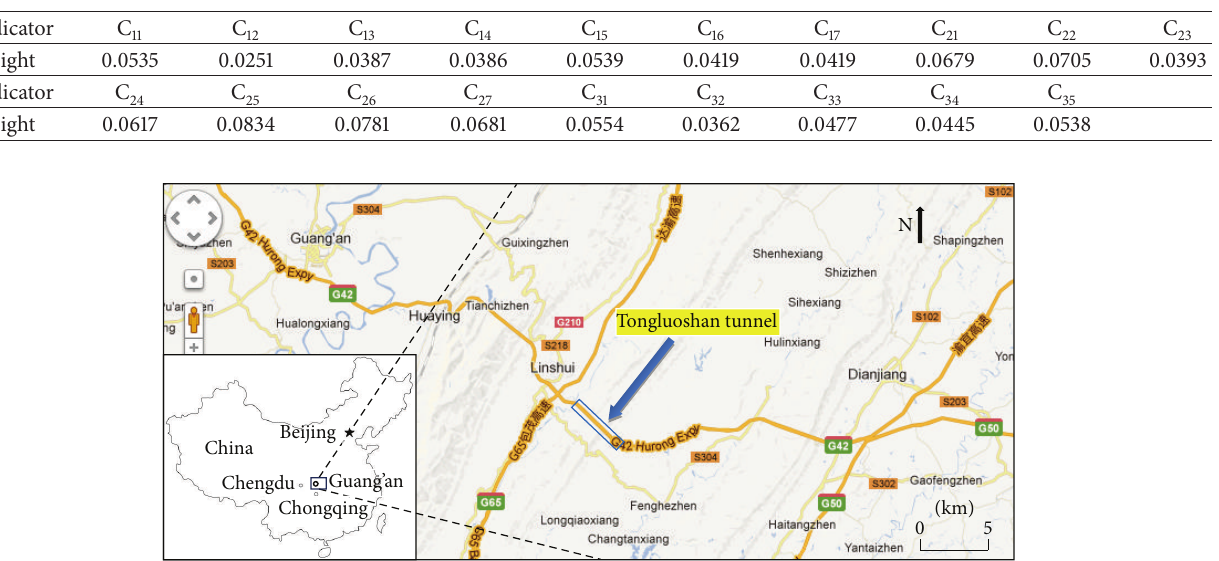
Figure 1: Location map of Tongluoshan